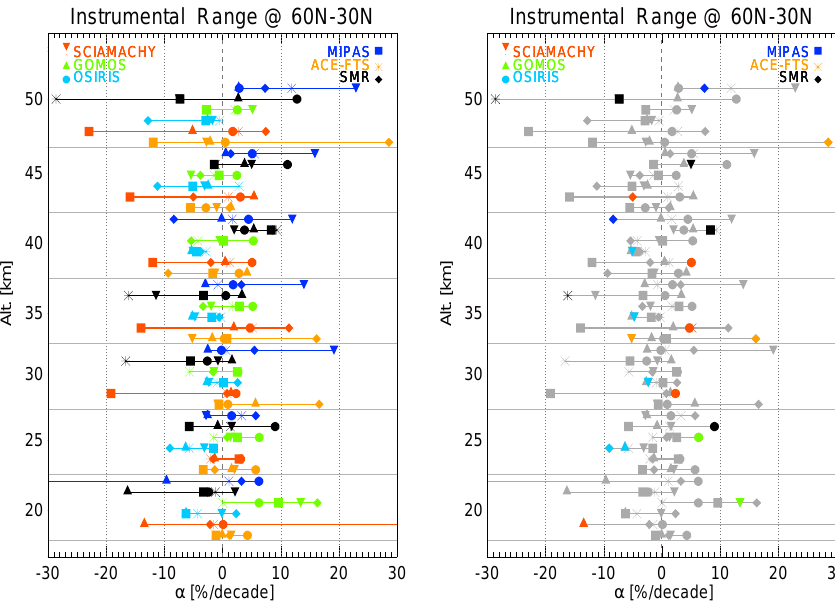
Figure 8. Same as Fig. 7 but for the northern middle latitudes (30–60 ◦ N).